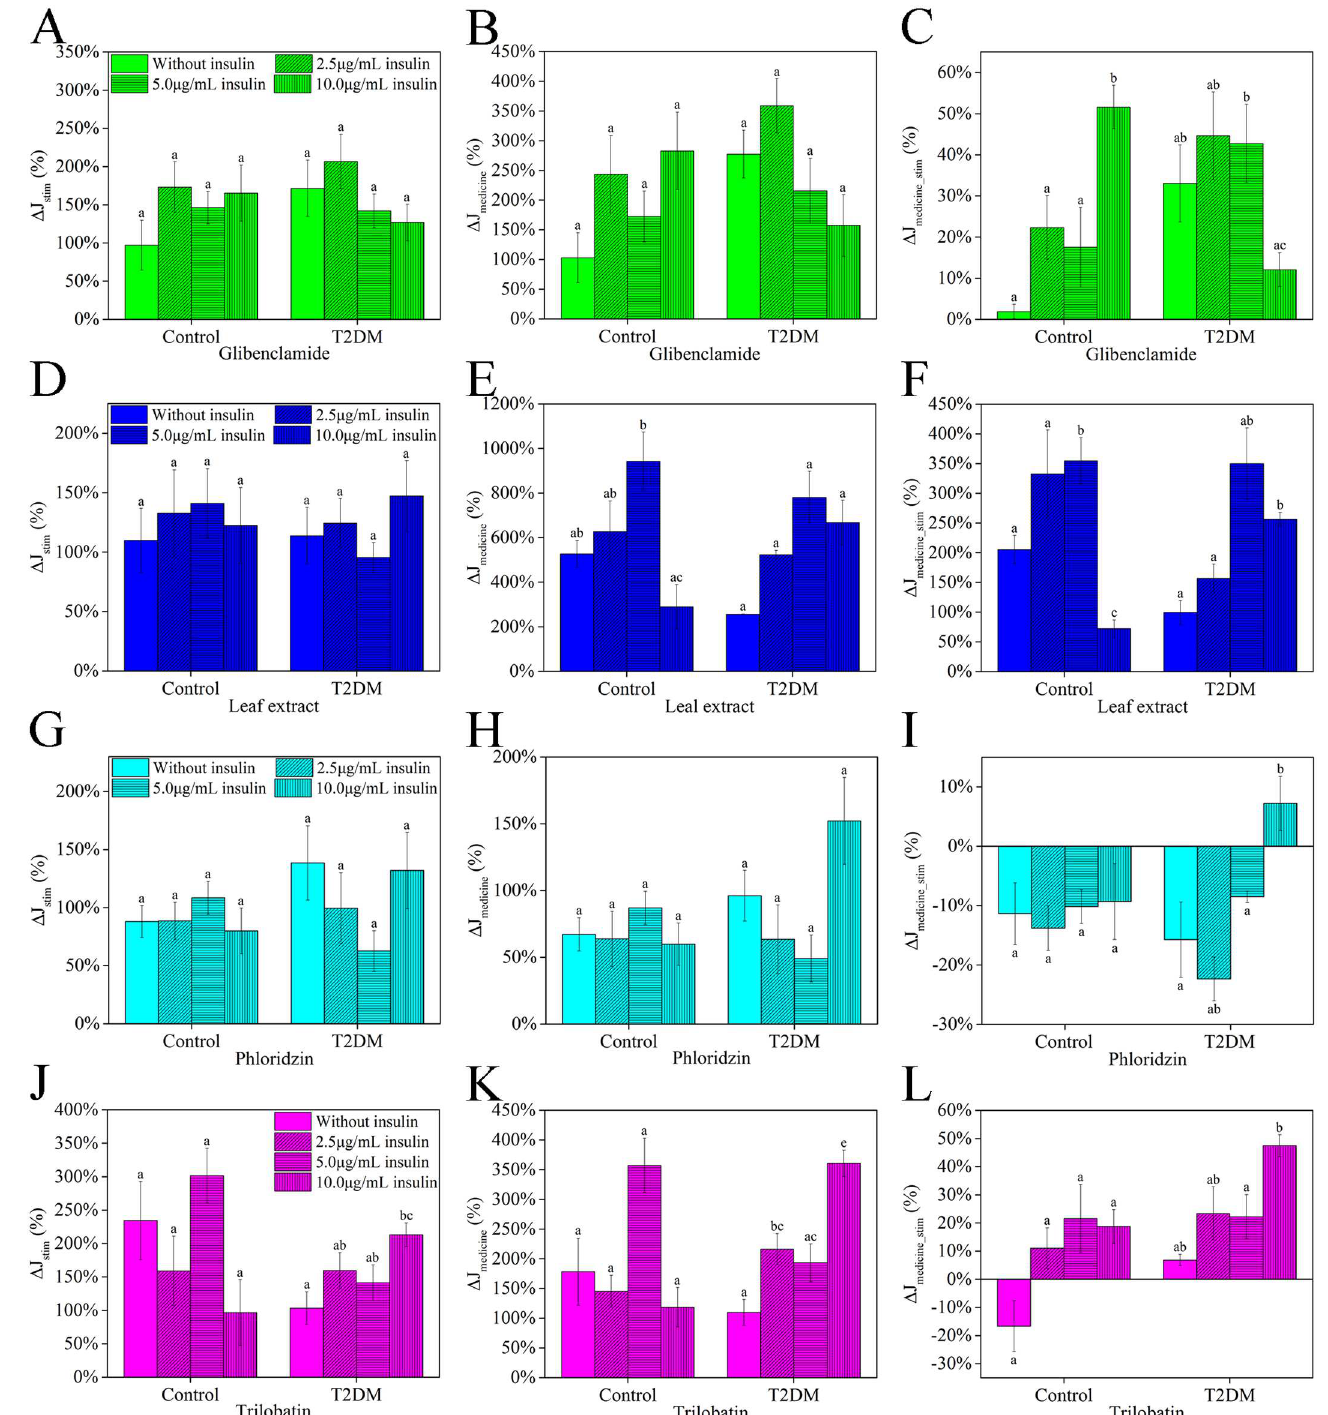
Fig 7. Effect of leaf extractsfrom L . polystachyus Rehd. on Δ J of glucose mean influx. Different colors mean different treatment, and different shapes mean different level of insulinin Hanks’. First column shown Δ J stim , second column shown Δ J medicien , and third column shown Δ J medicine_stim . The data were analyzedwith ANOVA. The values are expressed as the mean ± SEM, n = 6. Columns labeledwith different letters are significantly different at P <